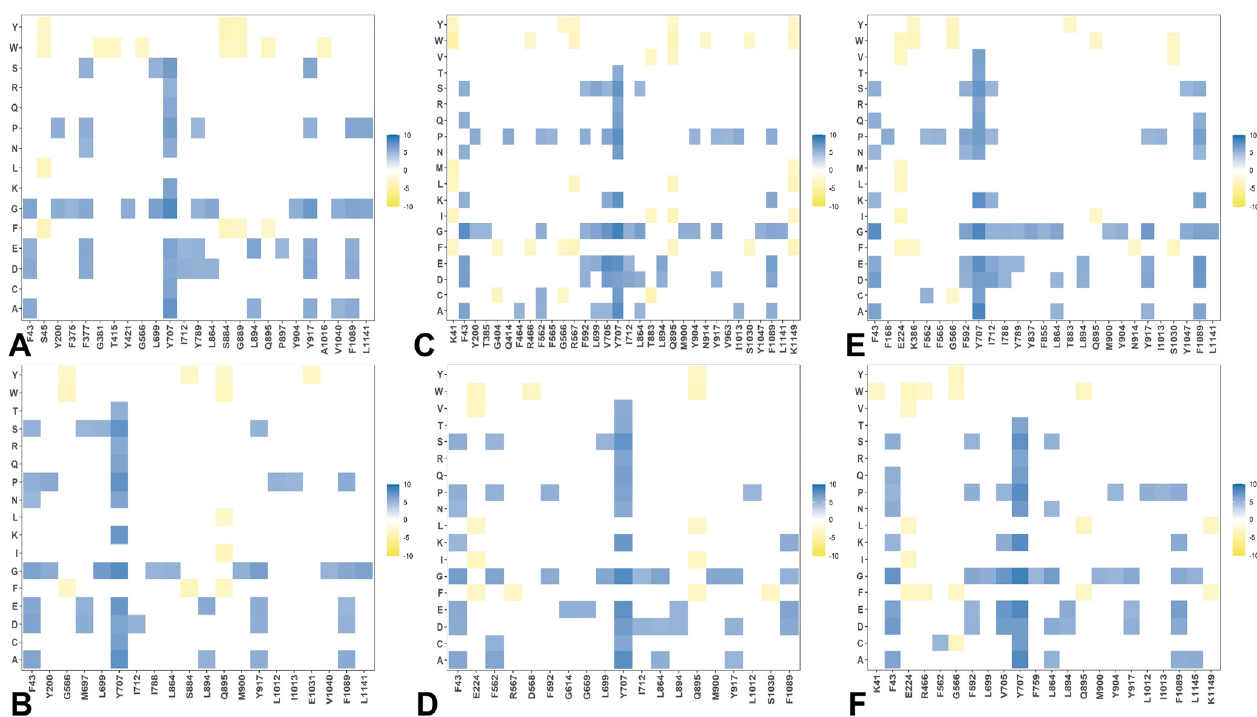
Figure 7. Ensemble-based dynamic mutational profiling of the S trimer inter-protomer interfacial interfaces in the S Omicron trimers. The mutational scanning heatmaps are shown for the inter-protomer residues in the S Omicron BA.1 closed trimer, pdb id 7WK2 ( A ). S Omicron BA.1 open trimer, pdb id 7WK3 ( B ). S Omicron BA.2 closed trimer, pdb id 7XIX ( C ). S Omicron BA.2 open trimer, pdb id 7XIW ( D ). S Omicron BA.2.75 closed trimer, pdb id 7YQU ( E ). S Omicron BA.2.75 open trimer, pdb id 7YQT ( F ). The standard errors of the mean for binding free energy changes were based on MD trajectories and selected samples (a total of 1000 samples) are within ~0.15–0.23 kcal/mol using averages over 10 different CG-BD trajectories. The mutational scanning heatmaps are filtered to focus on residues where mutations induce extremely large destabilization changes with ΔΔ G values > 5.0 kcal/mol (blue scale) as well as positions and mutations that yielded signi fi cant stabilization changes ΔΔ G values< − 3kcal/mol (yellow scale). The positions/mutations that do not meet these thresholds are shown in white. According to the maps, only about 30 residues from all structures were identi fi ed as important.